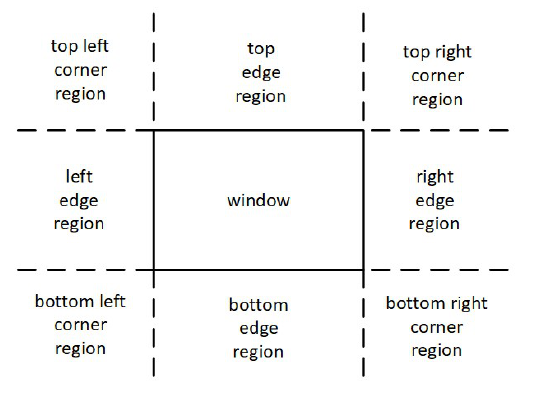
Figure 9. NLN divides screen space into nine regions, like CS.